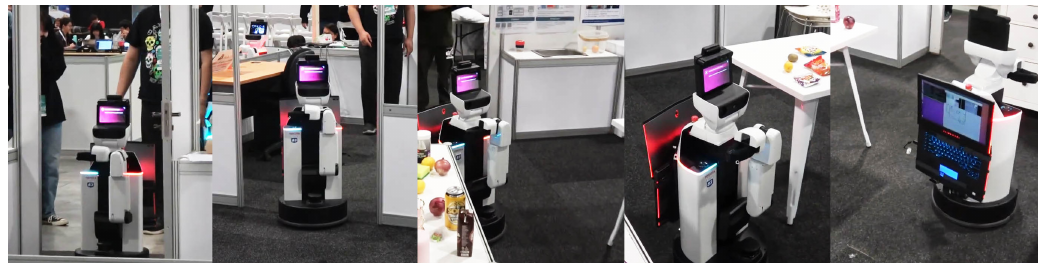
Figure 12. The HSR navigating in a tight indoor